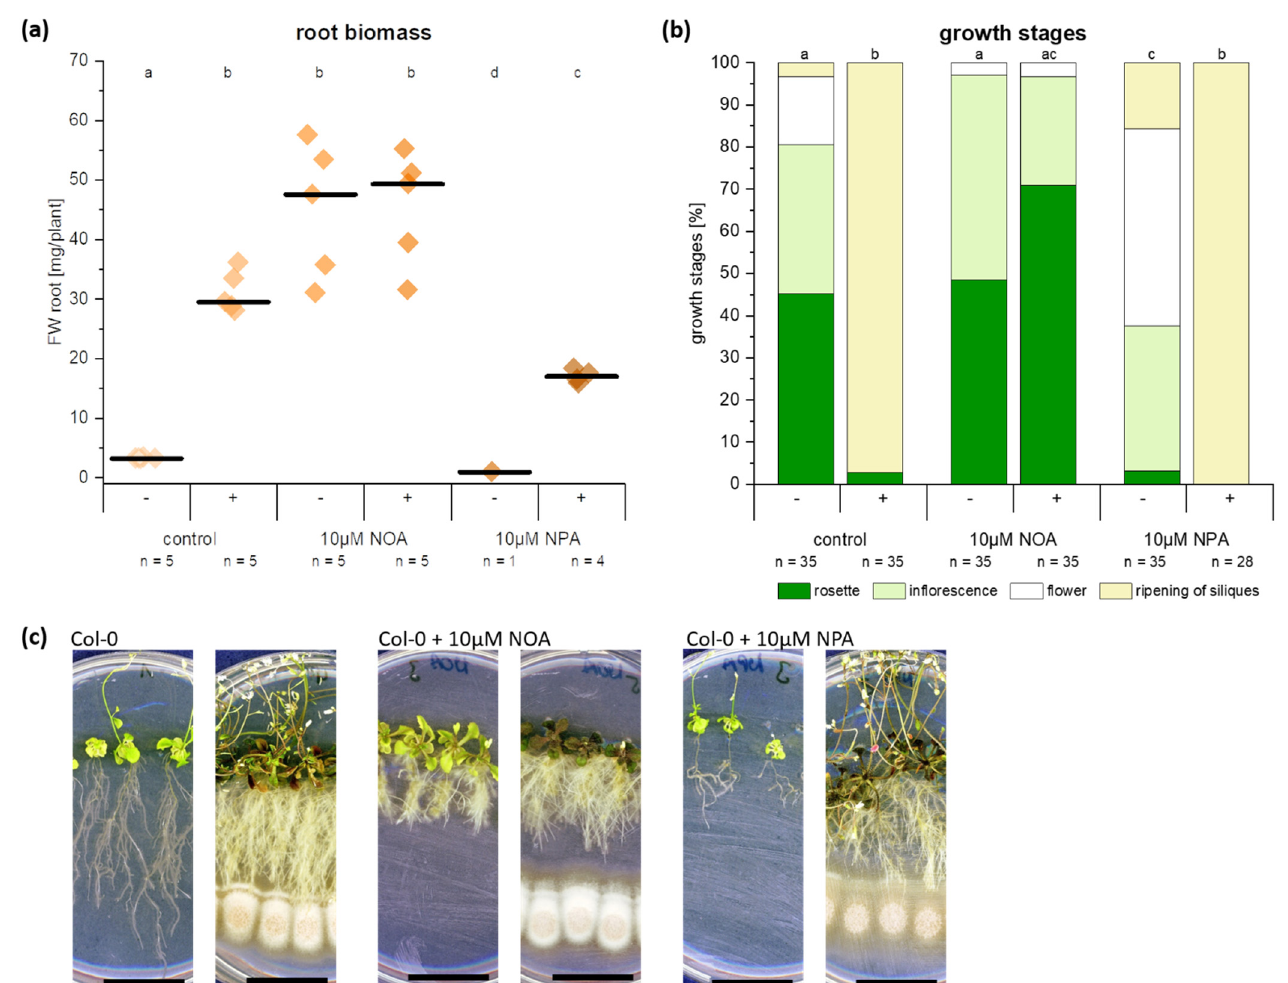
Figure 6. Co-cultivation of A. thaliana and C. asteris with IAA transport inhibitors 2-naphthoxyacetic acid (NOA) and N-1-naphtylphthalamic acid (NPA). A. thaliana and C. asteris were co-cultivated on ½ MS/MEAlow including either 10µM NOA or 10µM NPA under long day conditions for 35 days. ( a ) Root biomass and ( b ) growth stages of A. thaliana plants. Small letters indicate significant differences. –median. ( c ) Growth of A. thaliana and C. asteris on NOA or NPA containing